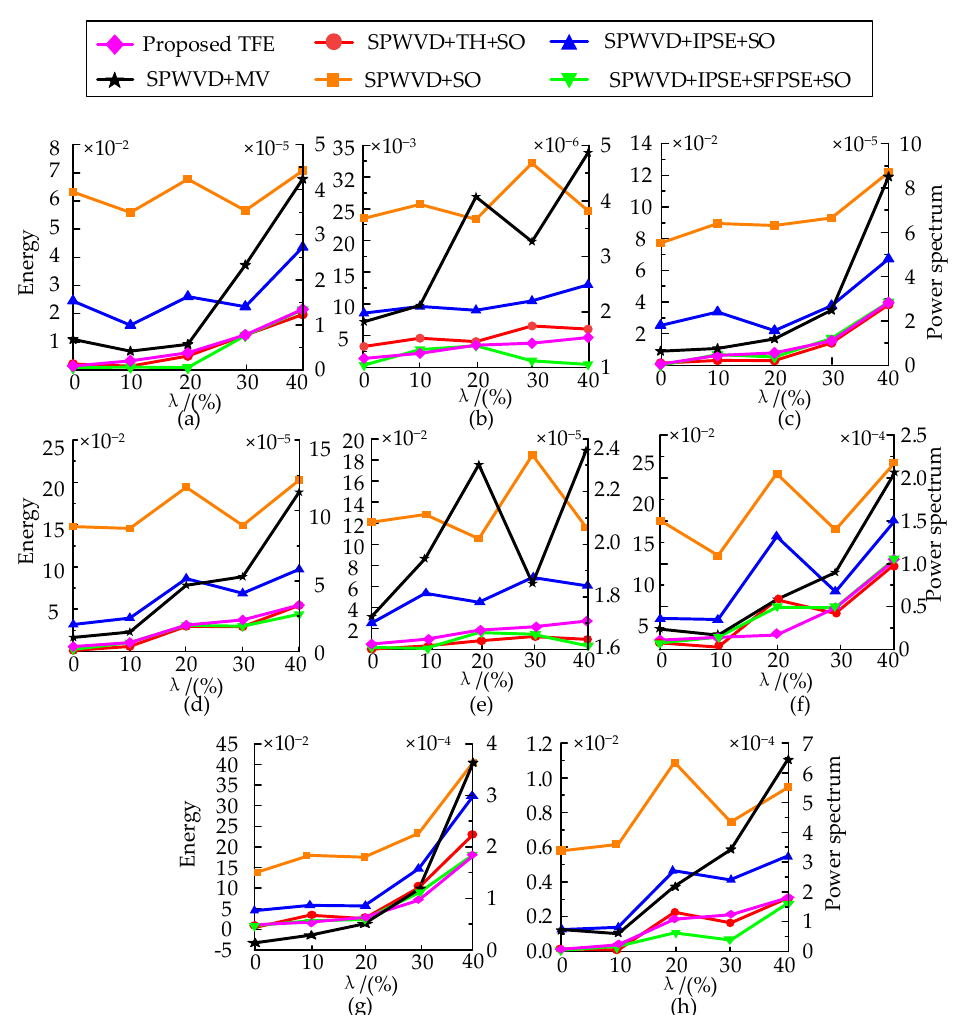
Figure 16. The fault features extracted from different signals under various working conditions: ( a ) The surge speed at 0.3 m/s; ( b ) The surge speed at 0.2 m/s; ( c ) The surge speed at 0.4 m/s; ( d ) The surge speed at 0.5 m/s; ( e ) The change rate of the control voltage at 0.2 m/s; ( f ) The change rate of the control voltage at 0.3 m/s; ( g ) The change rate of the control voltage at 0.4 m/s; ( h ) The change rate of the control voltage at 0.5 m/s.